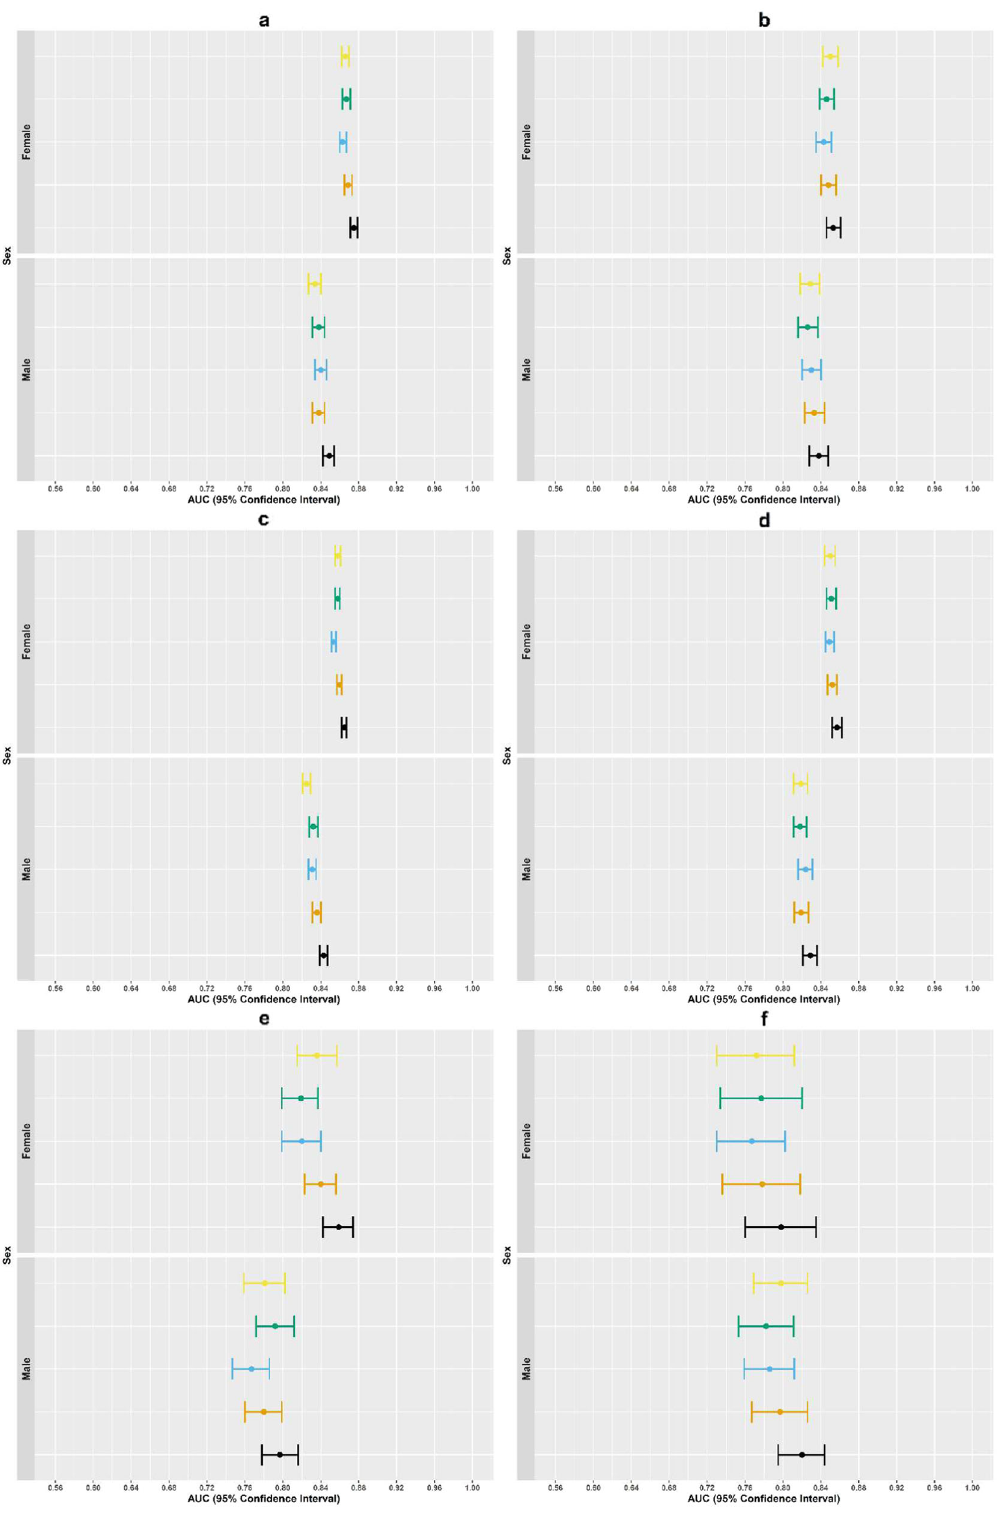
Fig. 4 Variation in area under the receiver operating curve (AUC) across men and women for all suicide risk prediction models. Dots represent AUC in left out validation sample and the lines represent upper and lower bounds on 95% con fi dence intervals based on 10,000 bootstrap samples. Each fi gure panel represents variation in AUC across mend and women for different samples, outcomes, and follow-up periods. ( a ): 30-day suicide attempt prediction models, mental health specialty visits; ( b ): 30-day suicide attempt prediction models, general medical visits. ( c ): 90-day suicide attempt prediction models, mental health specialty visits. ( d ): 90-day suicide attempt prediction models, general medical visits. ( e ): 90-day suicide prediction models, mental health specialty visits. ( f ): 30-day suicide prediction models, general medical visits. Original parsimonious (yellow); Logistic regression with lasso variable selection (green); Random forest (blue); Arti fi cial neural network (orange); Ensemble model using logistic regression, random forest, and arti fi cial neural network models with detailed temporal predictors